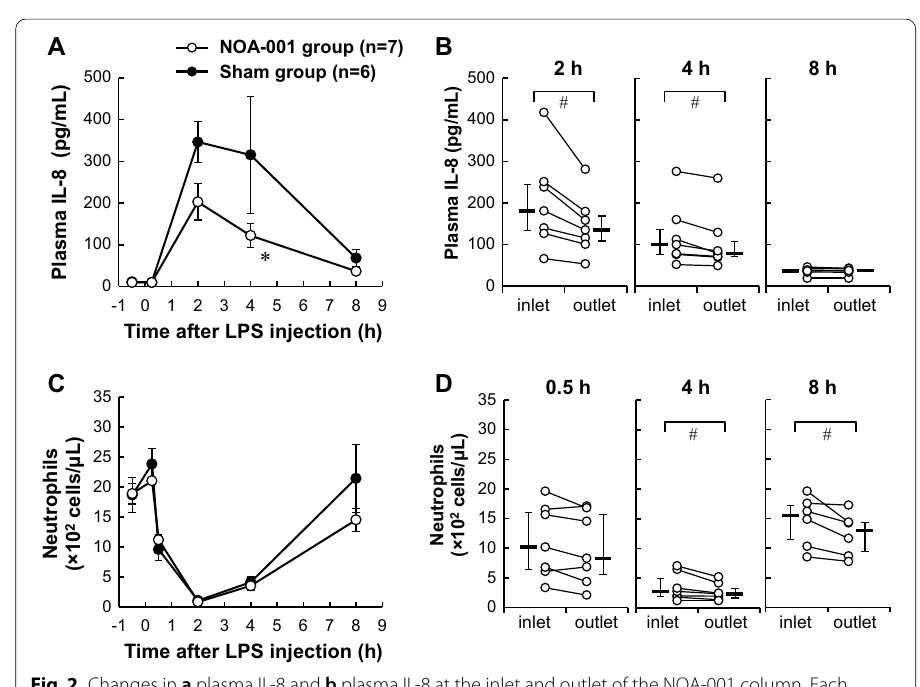
Fig. 2 Changes in a plasma IL-8 and b plasma IL-8 at the inlet and outlet of the NOA-001 column. Each symbol indicates an individual value. c Blood neutrophil counts. d Blood neutrophil counts at the inlet and outlet. Each symbol indicates an individual value ( b and d ). Data are shown as mean median and IQR ( b and d ). * p < 0.05 for NOA-001 vs. sham by two way ANOVA with a Sidak post hoc test. # p < 0.05 for inlet vs. outlet by Wilcoxon signed-rank